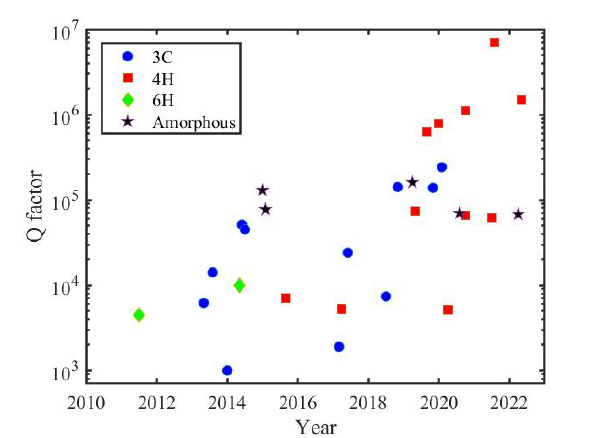
Figure 2. State of the art of SiC optical cavities